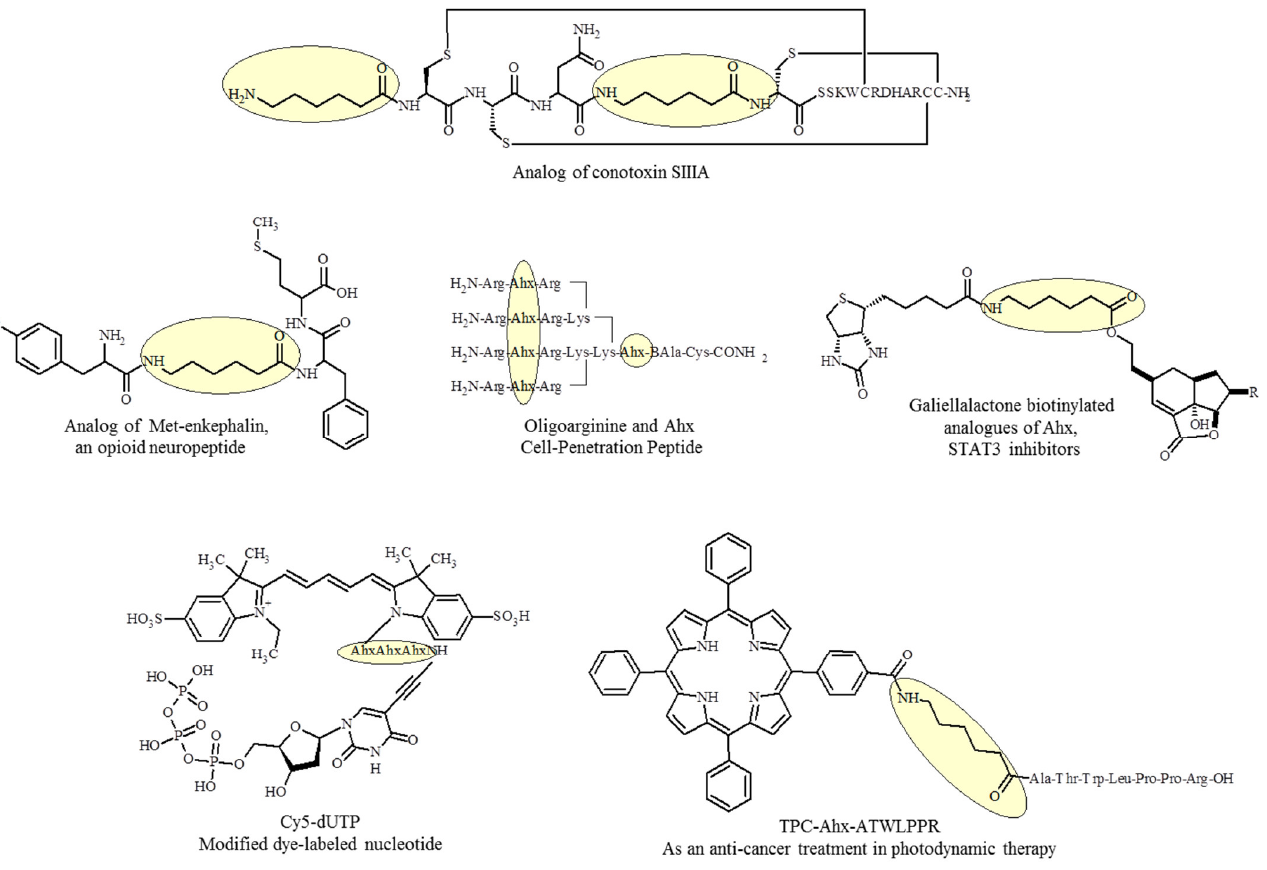
Figure 3. Ahx as fragment of molecules with biological